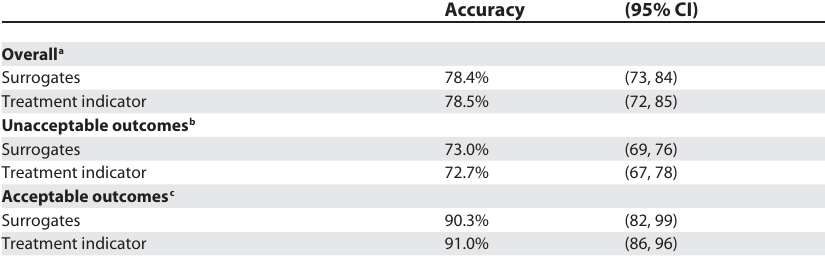
Table 2. Predictive Accuracy of Surrogates Versus a Preliminary Population-Based Treatment